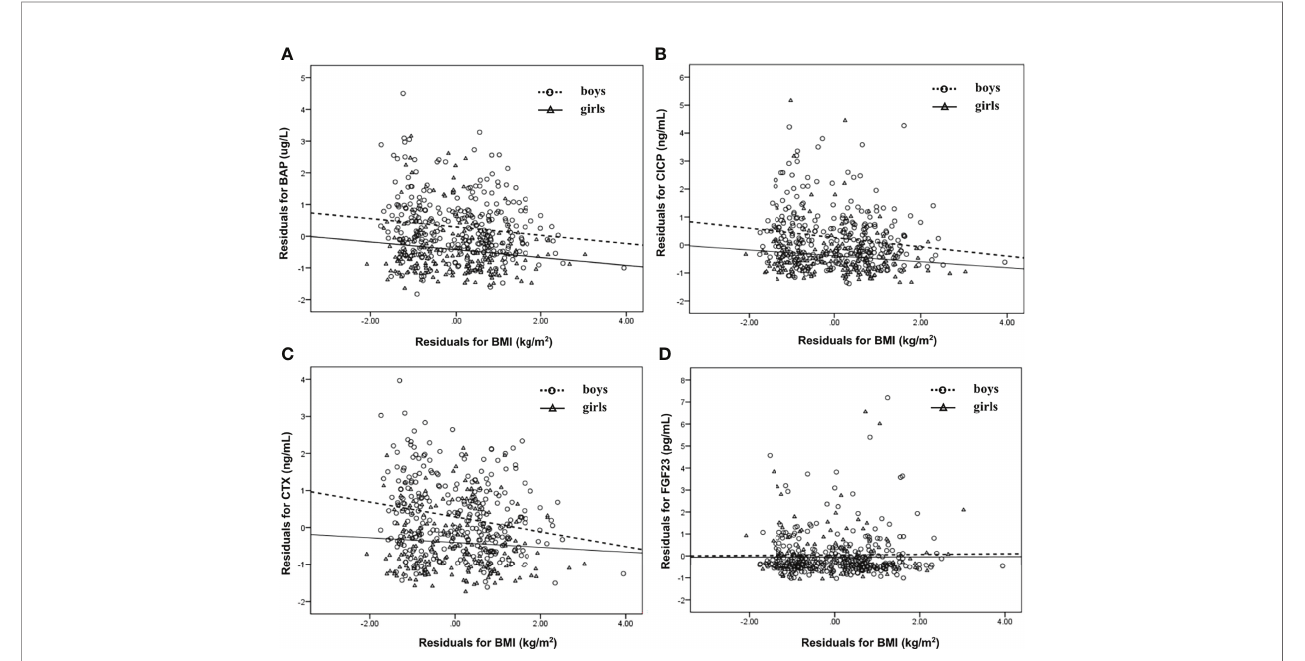
FIGURE 1 | Scatter plot that showing the relationship between BAP (A) , CICP (B) , CTX (C) , FGF23 (D) and BMI in boys and girls, respectively. Partial correlation analysis was performed after adjustment for age and pubertal stages. BAP, bone-speci fi c alkaline phosphatase; CICP, C-propeptide of type I procollagen; CTX, collagen type 1 C-terminal propeptide; FGF23, fi broblast growth factor 23; BMI, body mass index.